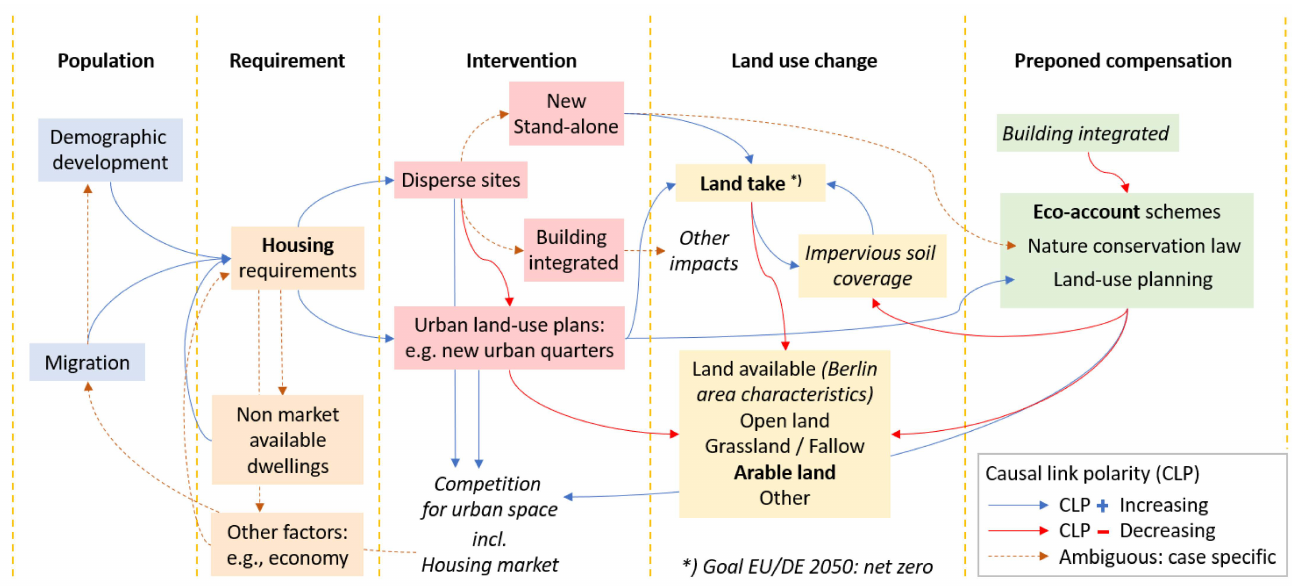
Figure 5. Main causal chains from population development to land-use change with regard to housing construction and its preponed compensation by eco-accounts; other types of intervention and project-related compensation are not considered; * refers to the net zero land take goal of Germany and the EU by 2050 [20], [23] (p.